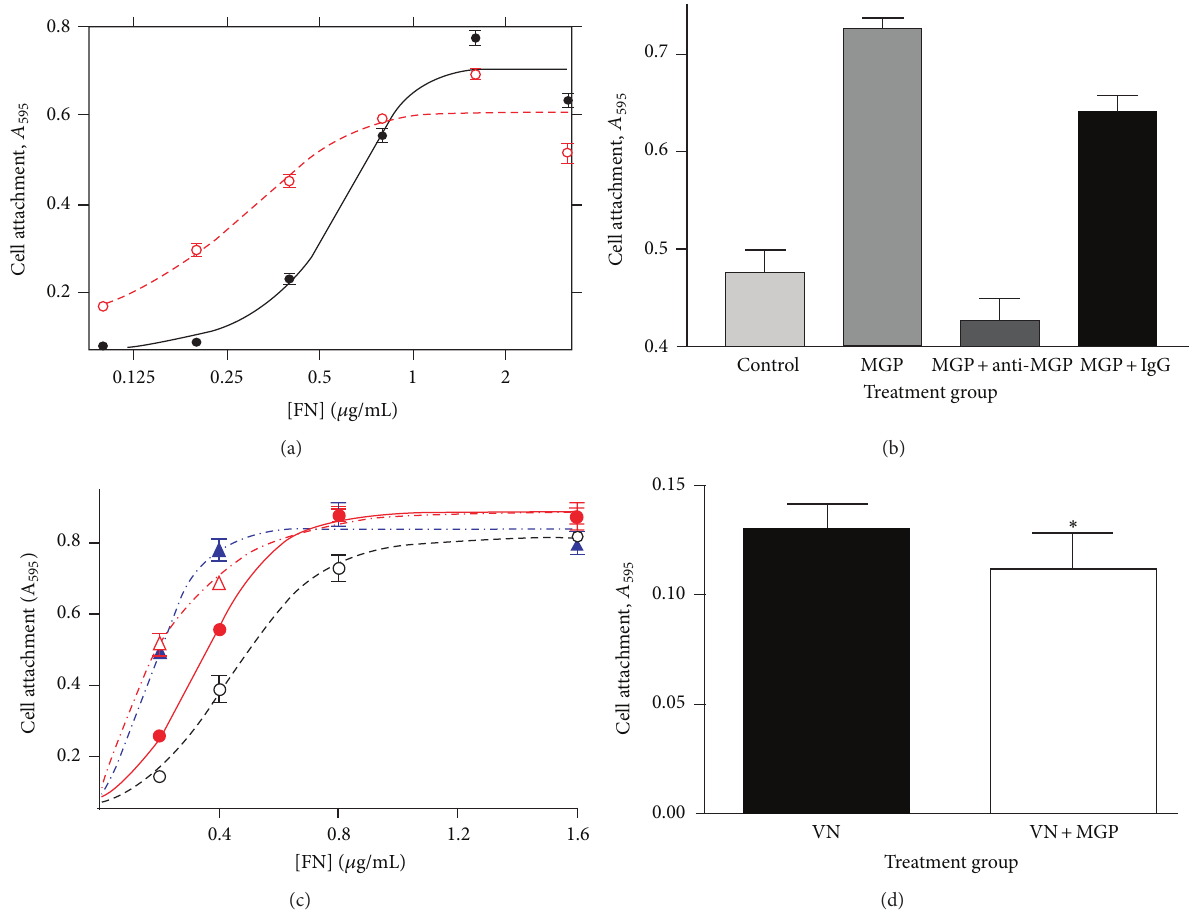
Figure 4: MGP enhances cell attachment to fibronectin. (a) The 𝑦 -axis is HeLa cell binding indicated as absorbance at 595 nm. The 𝑥 -axis is the log of fibronectin concentration from 0 to 3.3 𝜇 g/mL either with 3 𝜇 g/mL MGP ( ⃝ ) or control buffer ( e ). MGP did not enhance cell attachment for 0 fibronectin (not shown, logarithmic plot). (b) Anti-MGP IgG blocks the activity of MGP for enhancing cell attachment to fibronectin. Cell attachment was measured for control, 0.4 𝜇 g/mL fibronectin; MGP, 0.4 𝜇 g/mL fibronectin plus 3 𝜇 g/mL MGP; MGP + anti MGP, 𝜇 g/mL fibronectin plus 3 𝜇 g/mL MGP plus 31 𝜇 g/mL anti-MGP IgG; and MGP + IgG, 0.4 𝜇 g/mL fibronectin plus 𝜇 g/mL MGP plus 31 𝜇 g/mL rabbit polyclonal IgG. MGP and MGP + IgG were significantly different from control and MGP + antiMGP ( 𝑃 ≤ .05 ). (c) The concentration of MGP enhances cell attachment in a dose responsive manner but does not change maximum cell binding to fibronectin. Experiments were performed as in (a) except that MGP concentrations of 0.0, 0.8, 3, and 6 are compared, and the highest concentration of fibronectin is 1.6 𝜇 g/mL. No MGP ( ⃝ ); 0.8 𝜇 g/mL MGP ( e ); 3 𝜇 g/mL MGP ( 󳵻 ); and 6 𝜇 g/mL MGP ( 󳵳 ). Error bars are SEM for 4–6 replicate binding assays for each data point. Lines are nonlinear regression lines derived by Prism software. (d) MGP inhibits cell binding to vitronectin. VN, 0.2 𝜇 g/mL vitronectin; VN + MGP, 0.2 𝜇 g/mL vitronectin plus 0.8 𝜇 g/mL MGP. Error Bars are SEM for 8 replicate binding assays. The ∗ indicates significant difference ( 𝑃 < .05